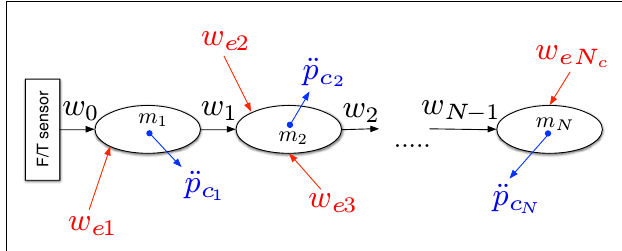
FIGURE 4 | Sketch of a kinematic chain with an embedded F/T sensor . Although the sketch refers to a serial chain, the theoretical framework holds also in the case of multiple-branches articulated chains (see, for example, the torso sub-chain in Figure 3